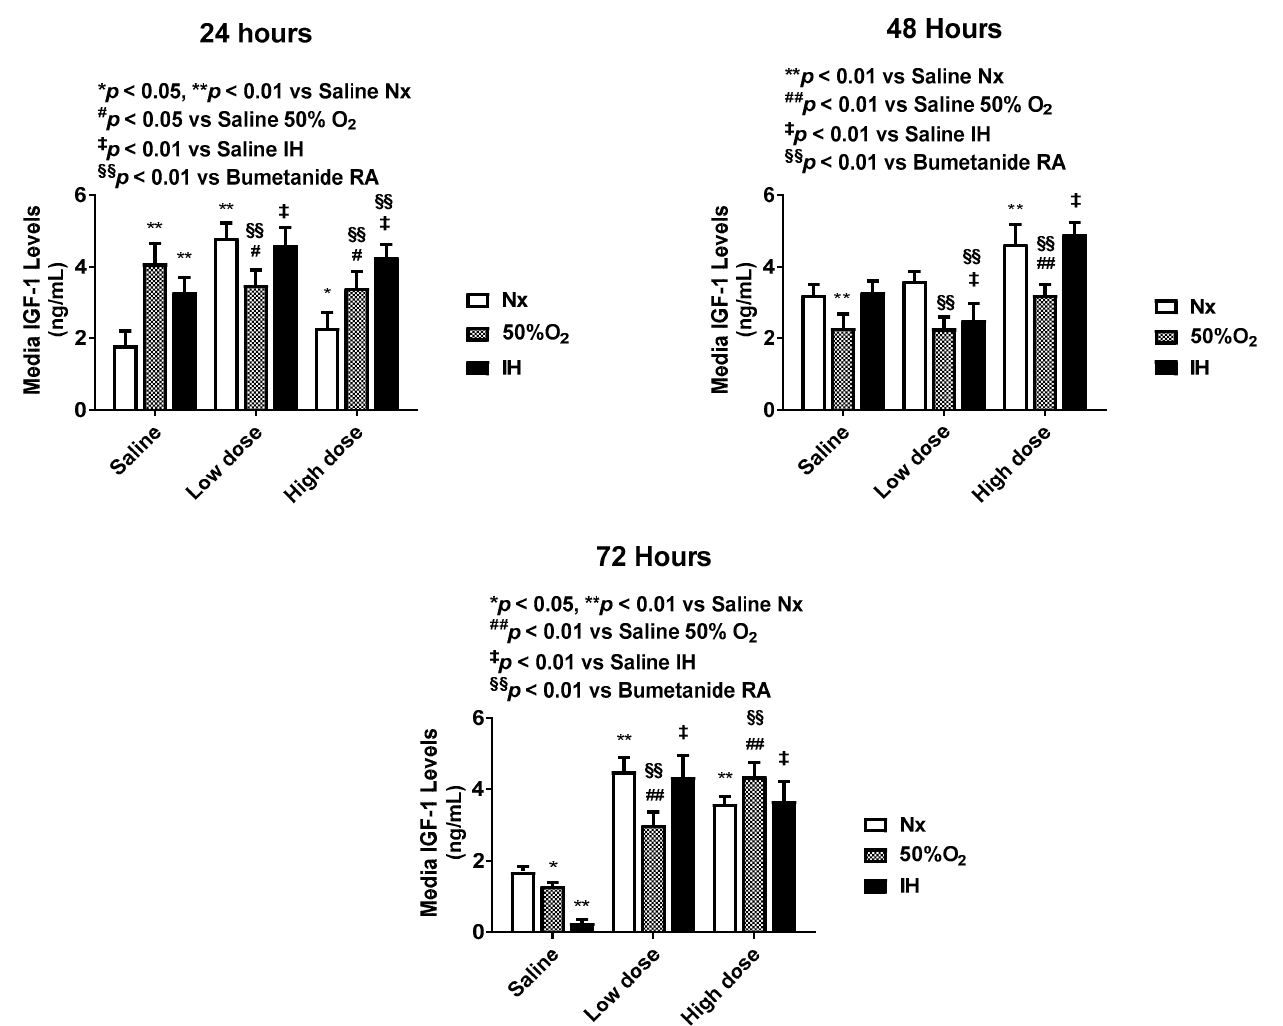
Figure 7. Dose-response effect of bumetanide on insulin-like growth factor (IGF)-1 levels in the media from cultured human microvascular retinal endothelial cells (HMRECs) exposed to normoxia (white bar), hyperoxia (50% O 2 , shaded bar), or intermittent hypoxia (IH, black bar) for 24, 48, or 72 h. Data were analyzed using two-way ANOVA with Dunnett’s post hoc test. Data are mean ± SEM (8 samples/group). * p < 0.05, ** p < 0.01 versus saline RA; # p < 0.05, ## p < 0.01 versus saline 50% O 2 ; ‡ p < 0.01 vs. saline IH; and §§ p < 0.01 versus bumetanide treatment in RA.